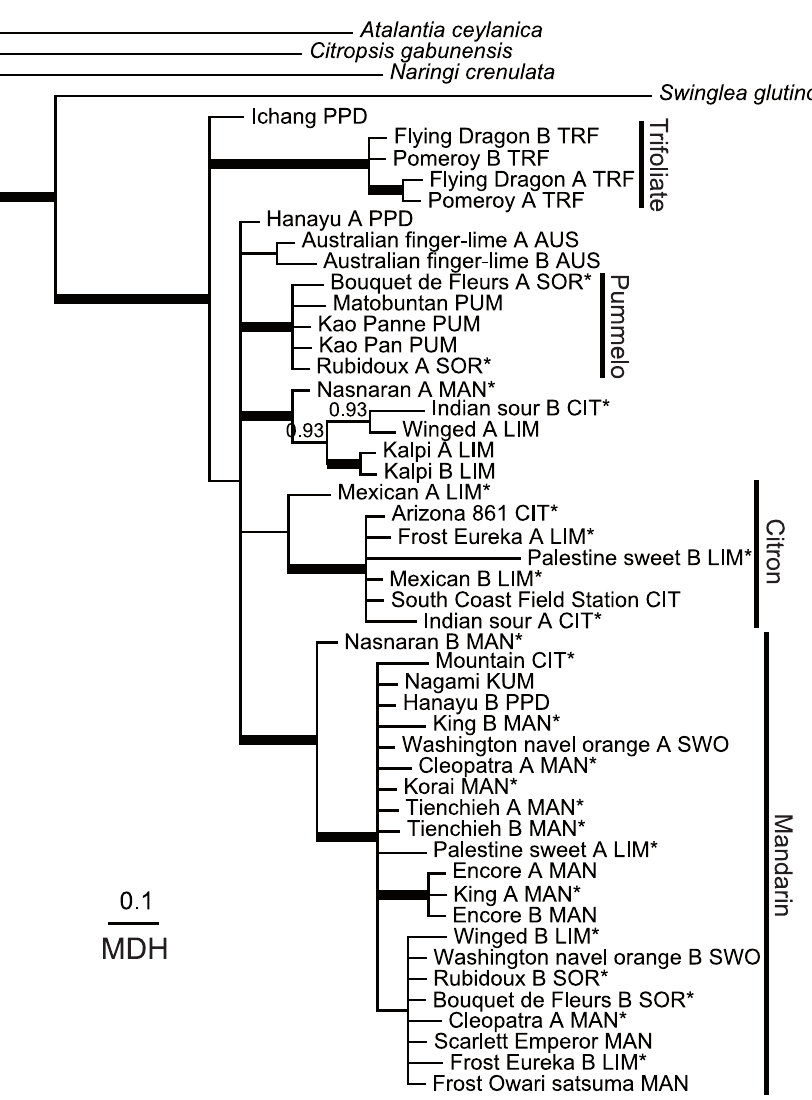
Figure 3. Bayesian consensus phylogram of MDH sequences from Citrus and related genera. Details as in Figure 1.